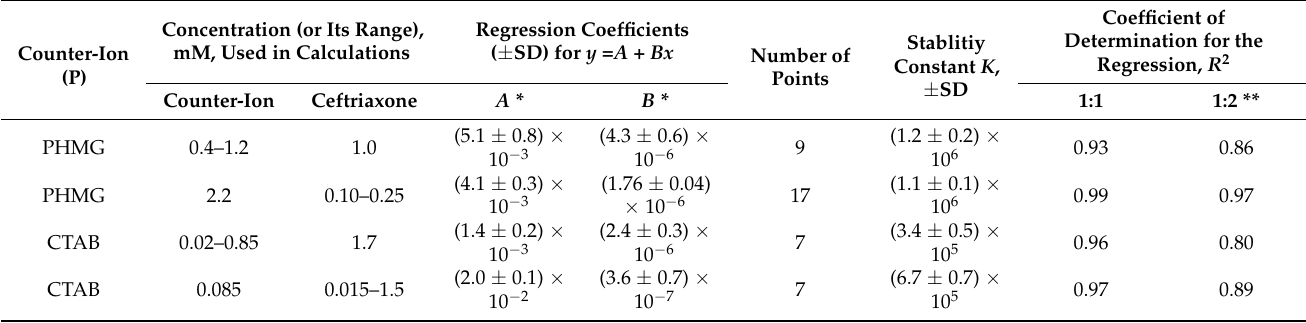
Table 1. Estimation of the stability constants of PHMG–ceftriaxone–dye and CTAB–ceftriaxone–dye aggregates by the Benesi–Hildebrand